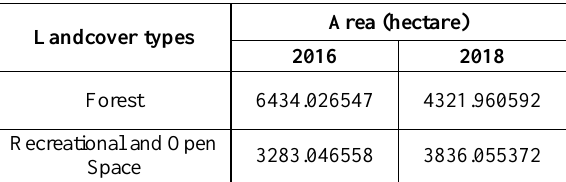
Table 3 Landcover area for year 2016 and 2018 for Johor Bahru